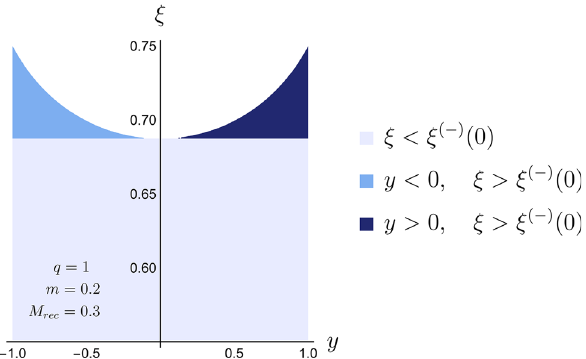
Fig. 3 Plot of the physical region in the ξ y plane. The shaded orange ( + ) (ξ, y ) is negative. It is physically equivalent to the region is where k n ( − ) (ξ, − y ) solution in the dark blue region. If we insisted (positive) k n upon considering only positive k n solutions, the blue region would be doubly covered, and the dark blue one would not be there